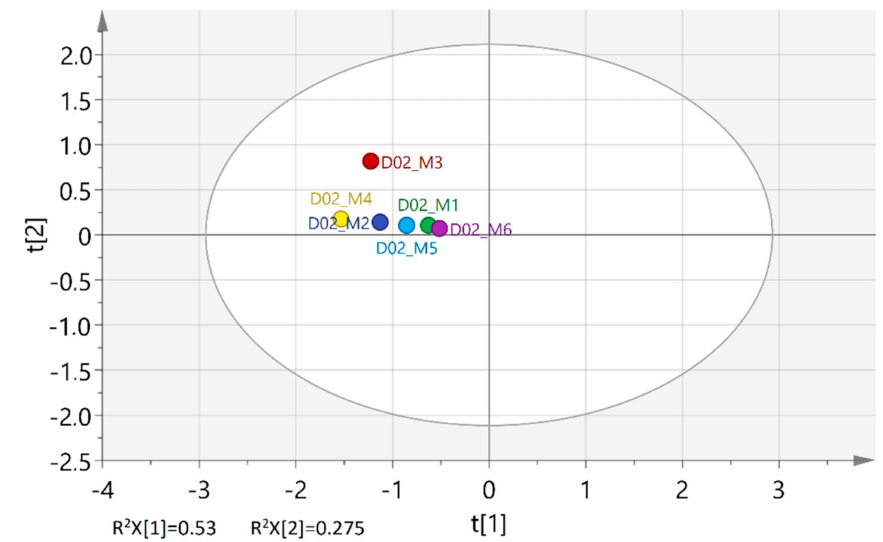
Figure 3. Scatterplot of PCA scores (t) along the first and second principal component of bay laurel leaf EO samples corresponding to six di ff erent sampling dates (M1–M6) from tree D02 (AUTh campus). Table 2. GC-MS data for the constituents of bay laurel leaf EOs corresponding to six di ff erent sampling dates (M1–M6) from tree D02 (AUTh